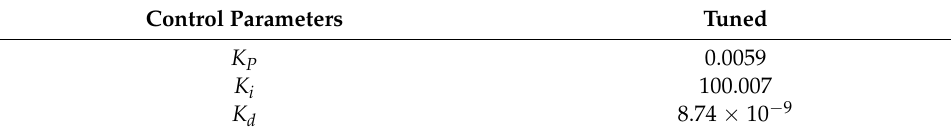
Table 3. PID coefficients tuned parameters.